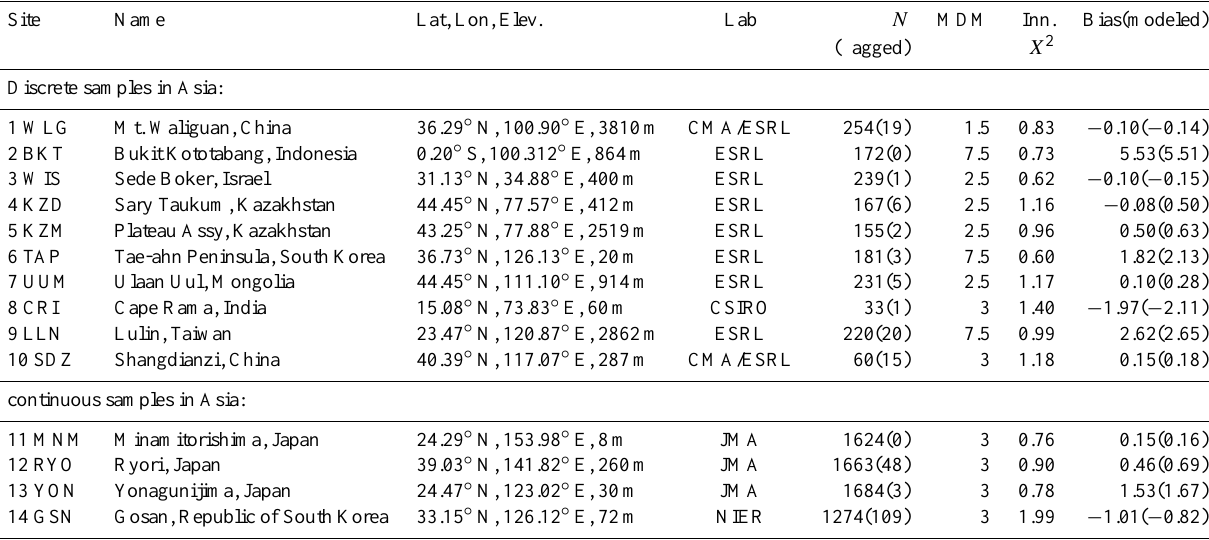
Table 1. Summary of the 14 Asian surface CO 2 observation sites assimilated between 1 January 2006 and 31 December 2010. The frequency of continuous data is one per day (when available), while discrete surface data point is generally available once per week. MDM (model–data mismatch) is a value assigned to a given site that is meant to quantify our expected ability to simulate observations and used to calculate the innovation X 2 (Inn. X 2 ) statistics. N denotes the number of observations used in CTDAS. Flagged observations refer to a model-minus- observation difference that exceeds 3 times the model–data mismatch, these observations are therefore excluded from assimilation. The bias is the average from posterior residuals (assimilated values–measured values), while the modeled bias is the average from prior residuals (modeled values–measured